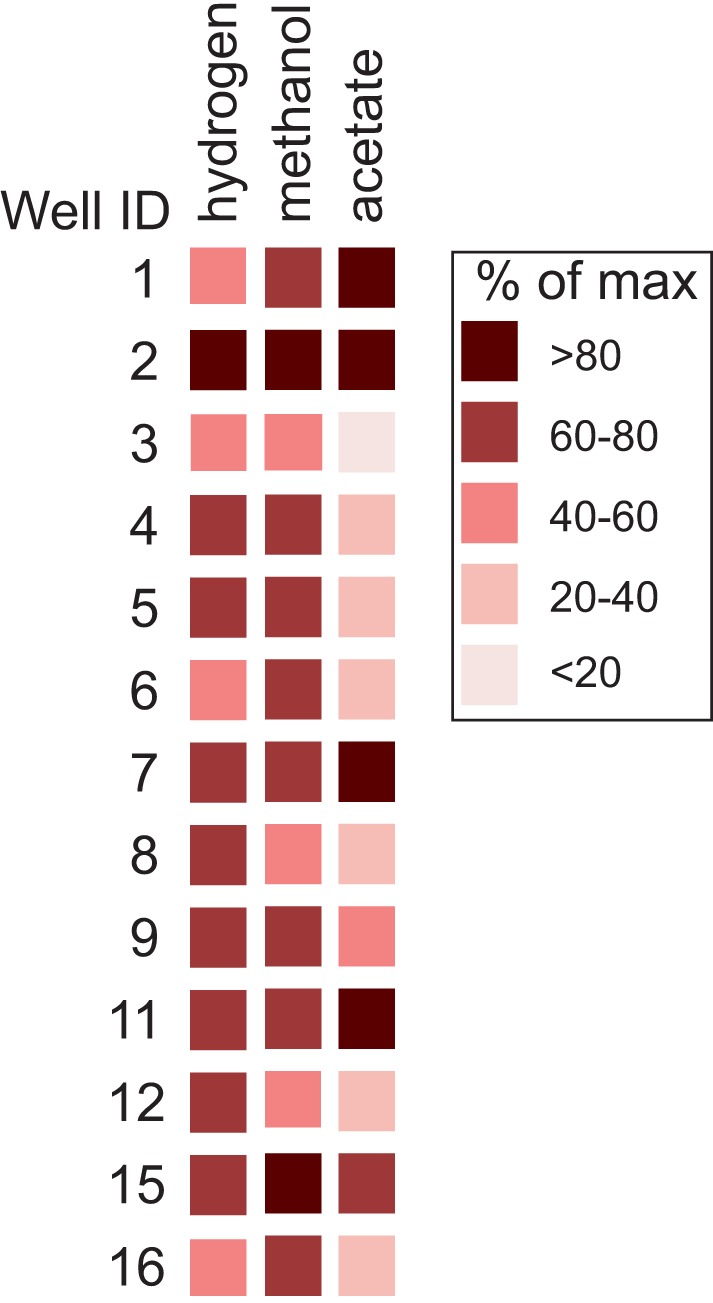
Abundance of methane that formed in cultures relative to the maximum amount possible per substrate. Results are normalized to levels of methane observed in control cultures.